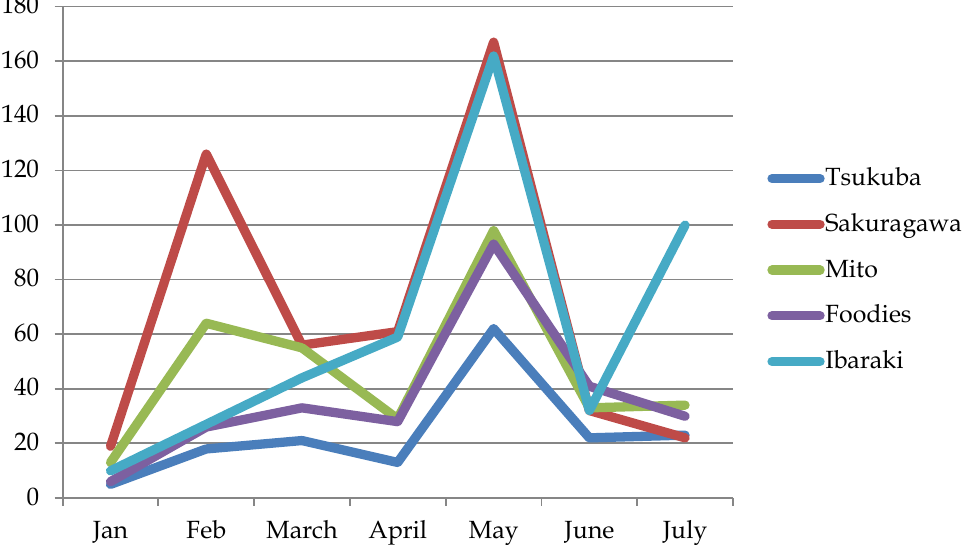
Figure 1: Total Posts on the Top Five Facebook Pages in Ibaraki, January to June